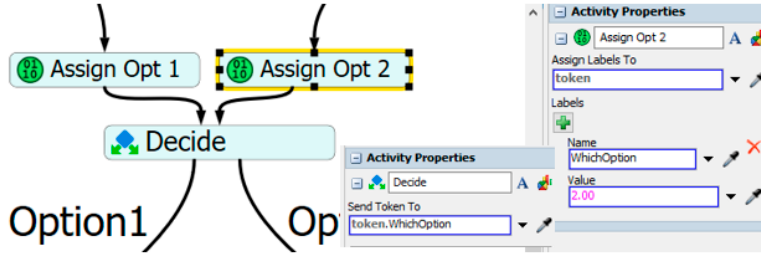
Figure 7. Example of a deterministic decision with FlexSim (label version).